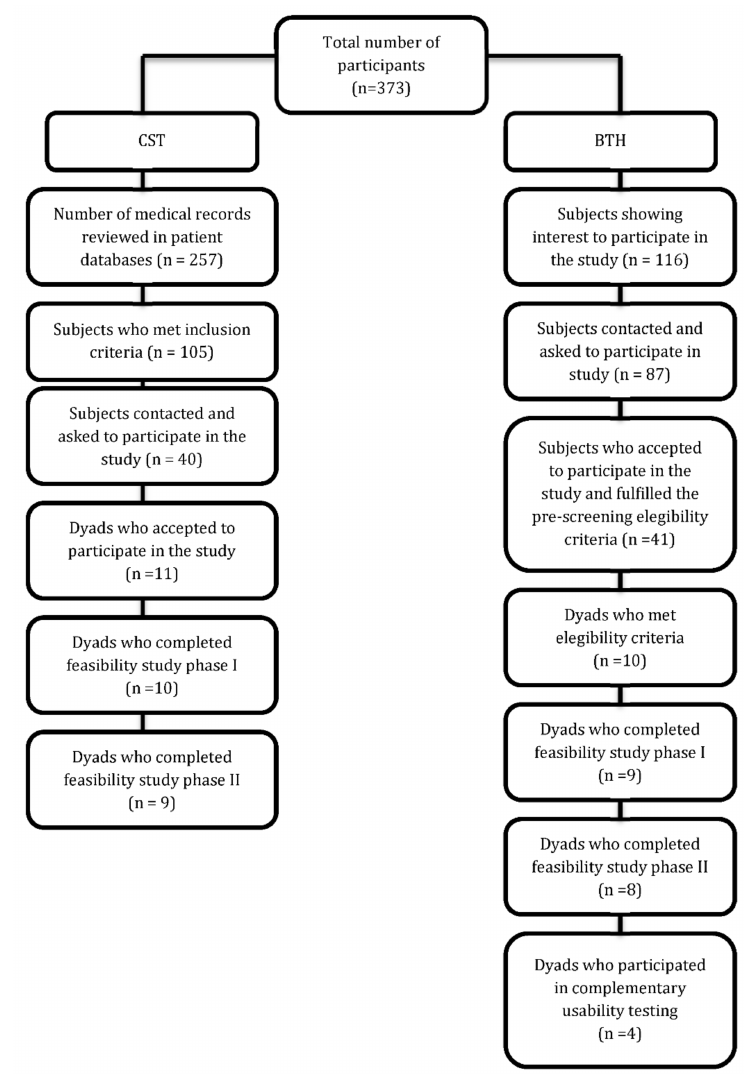
Figure 1. Flowchart for the feasibility